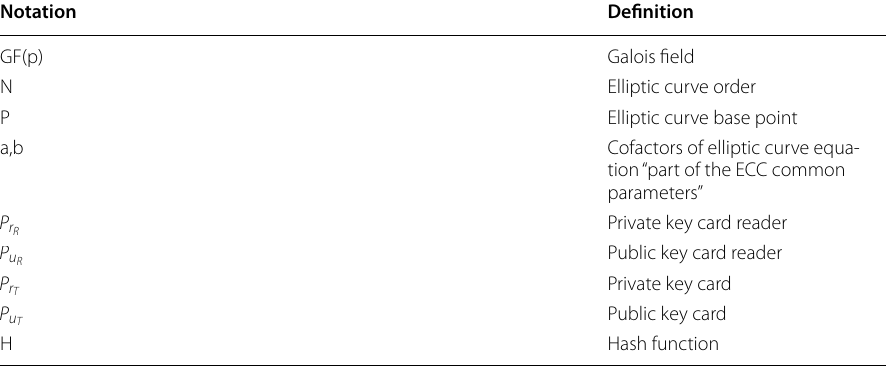
Table 3 Definition of notations used in the proposed scheme Notation